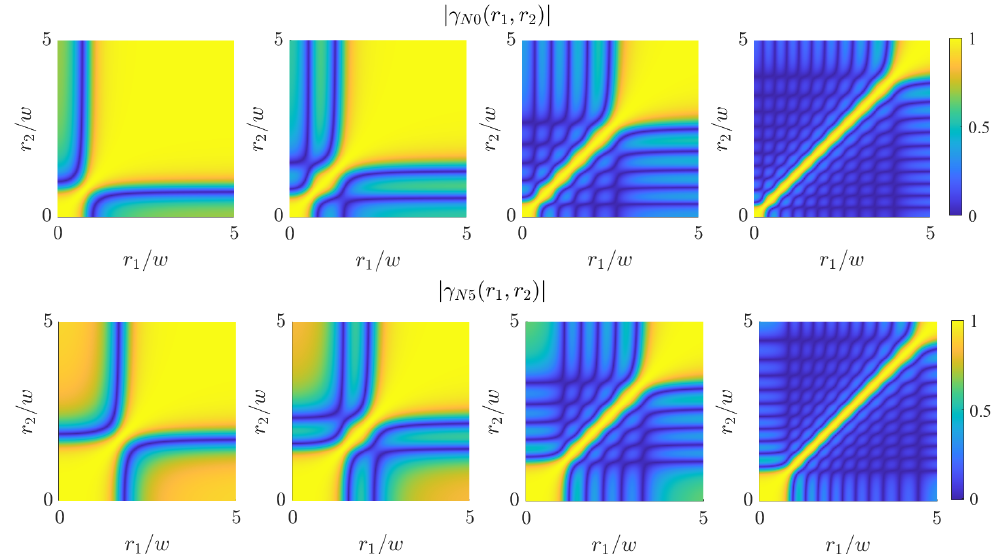
Figure 4. Absolute value of the complex degree of coherence and funtion in the r 1 r 2 plane for N = 1,2,5,10 (from left to right) and m = 0 (upper row) and m = 5 (lower